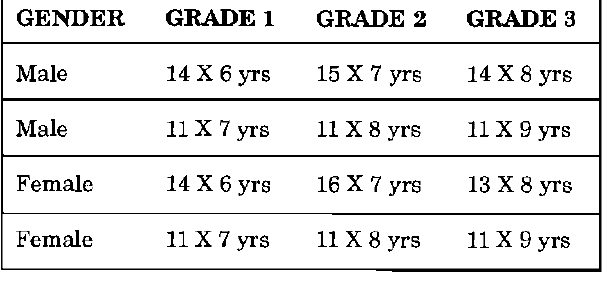
TABLE 2. Exposition of stratified population